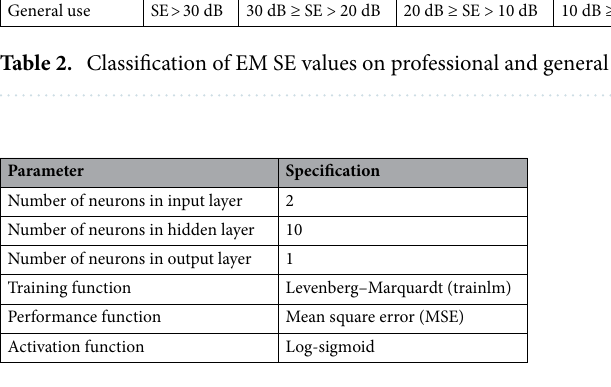
Table 3. Neural network configuration for the